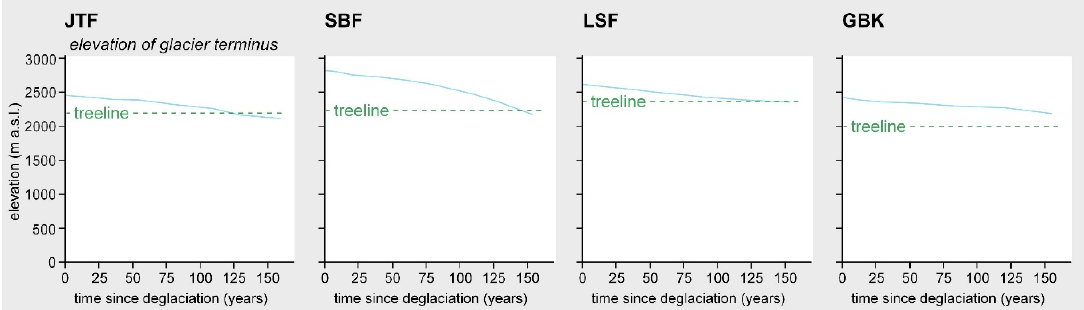
Figure 2. Gradual change in elevation of the glacier terminus since Little Ice Age (LIA) maximum extent roughly one and a half century ago (blue line) within the four glacier forelands studied. The green line indicates the elevation of the treeline, which did not differ from today during the cold phases of LIA.